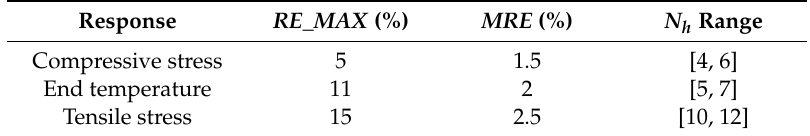
Table 4. Optimal node number range in the hidden layer for each response according to predefined error criteria.